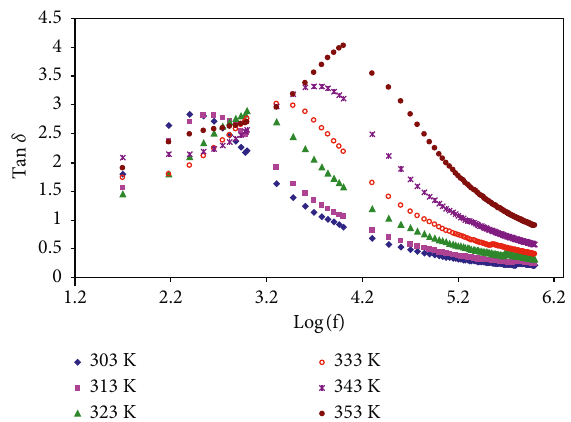
Figure 9: Loss tangent (tan δ ) versus frequency at selected tem- peratures for the PBS3 blend sample.